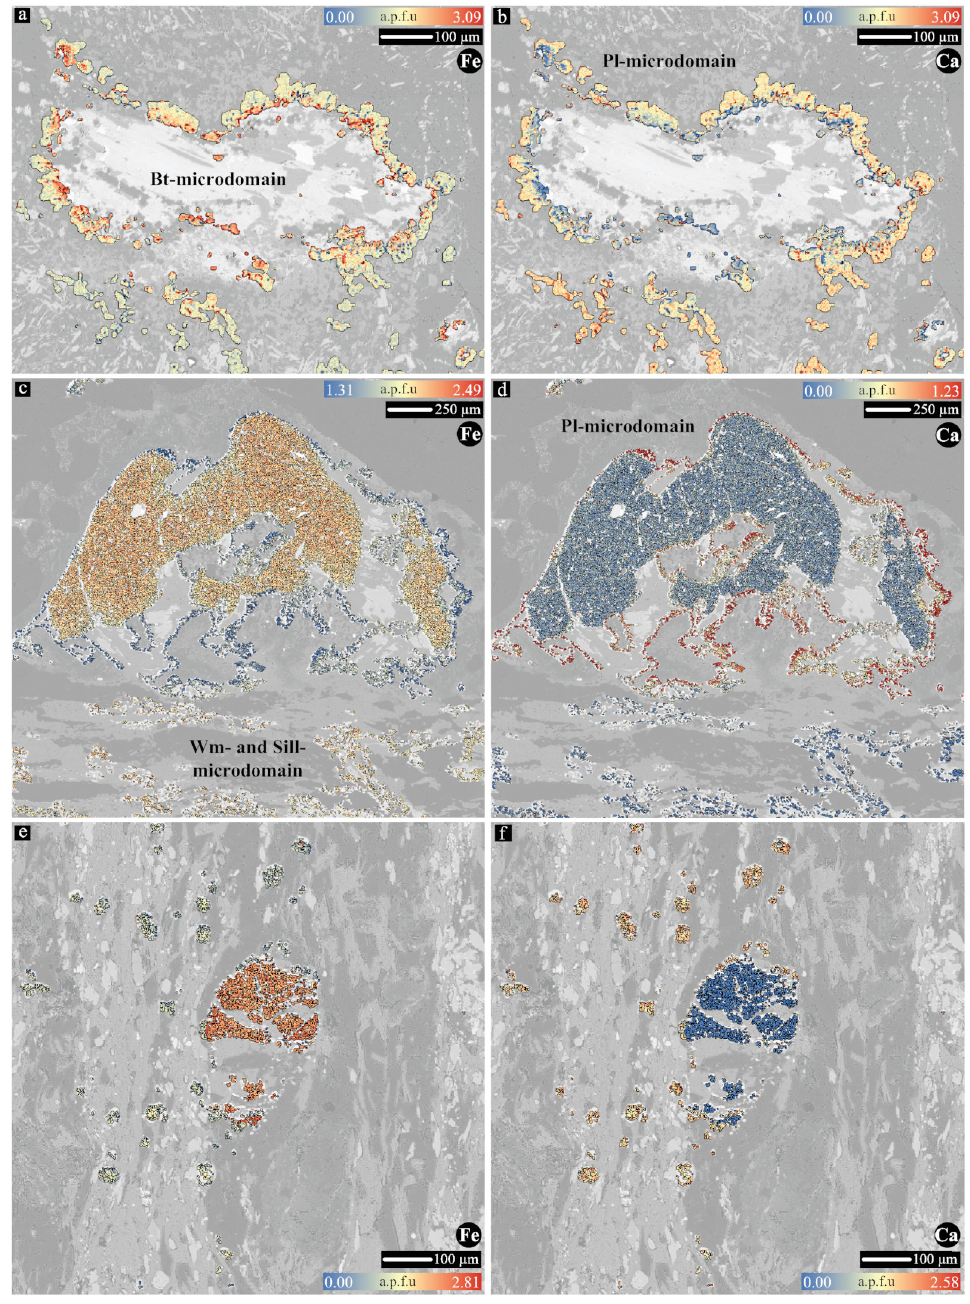
Figure 8. Calibrated maps of garnet: ( a , b ) calibrated maps of Fe and Ca of LdV garnets; ( c , d ) calibrated maps of Fe and Ca of MM garnets; ( e , f ) calibrated maps of Fe and Ca of RCT